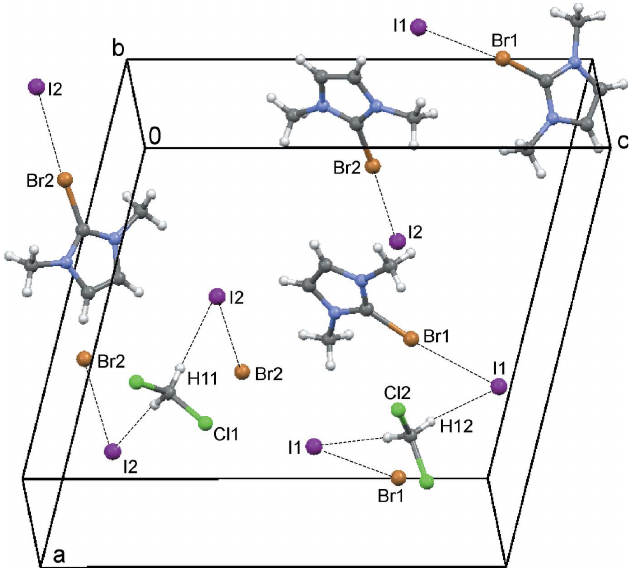
Figure 5 The crystal packing of compound 2 viewed along the b axis showing